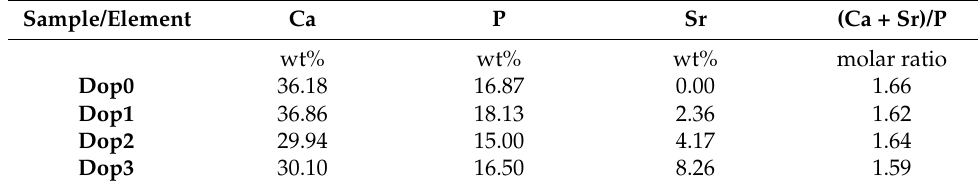
Table 1. Weight percentages (wt%) of Ca, Sr and P and (Ca + Sr)/P molar ratios for the solid-state- synthesized HAp samples, obtained by